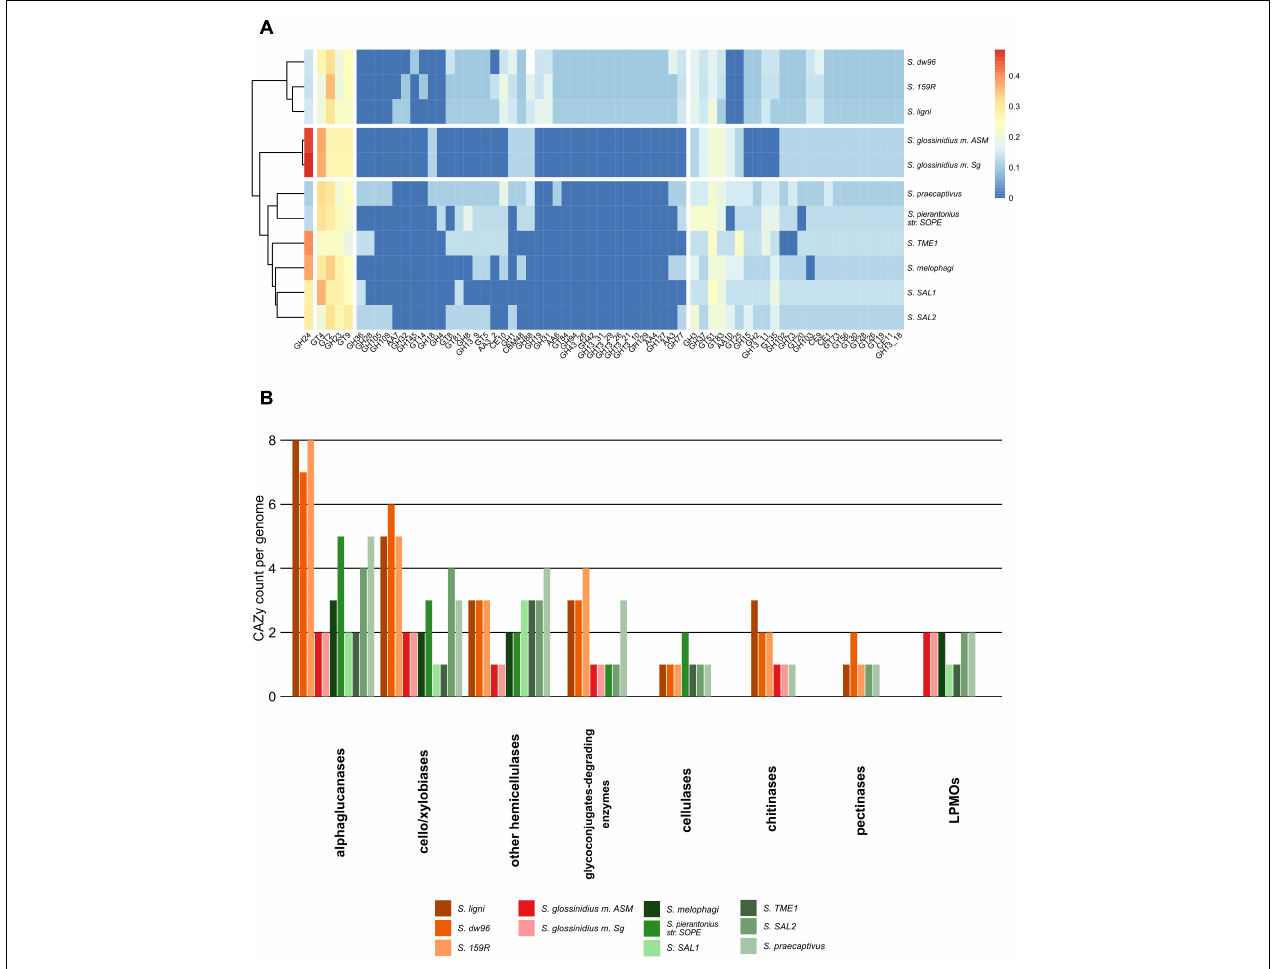
FIGURE 3 | CAZy presence in the Sodalis genomes. (A) CAZy heatmap with clustering analysis shows the CAZyme abundance pattern, which follows Sodalis guild differentiation into wood-associated strains, tsetse symbionts and other symbiotic strains. Legend shows transformed counts. (B) Functional annotation of the CAZymes found in the genomes of Sodalis genomes. Genes for labile substrate utilization, such as cello/xylobiose and α -glucan, are increased in deadwood-associated